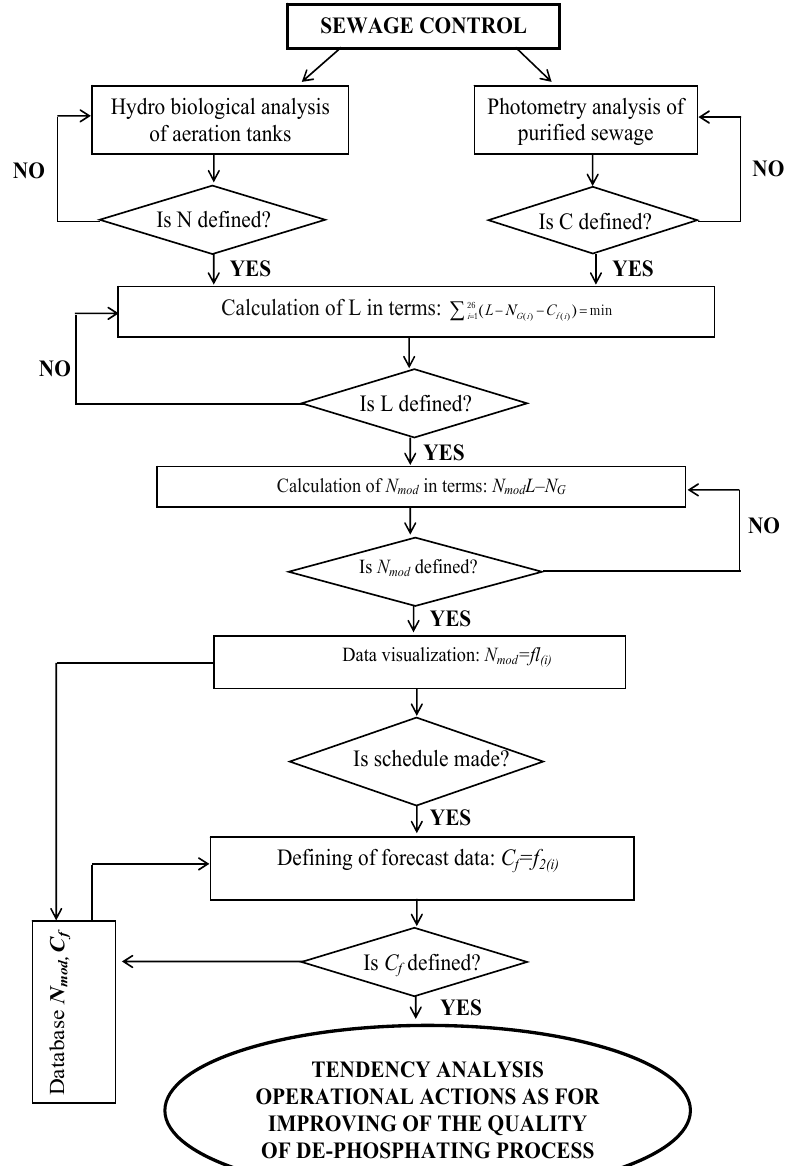
Fig. 1. Algorithm for de-phosphating